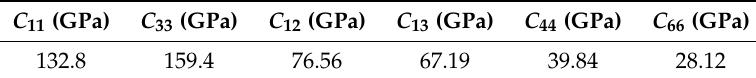
Table 1. Elasticity constants of Ti-6242 in the material coordinates (1172 K).